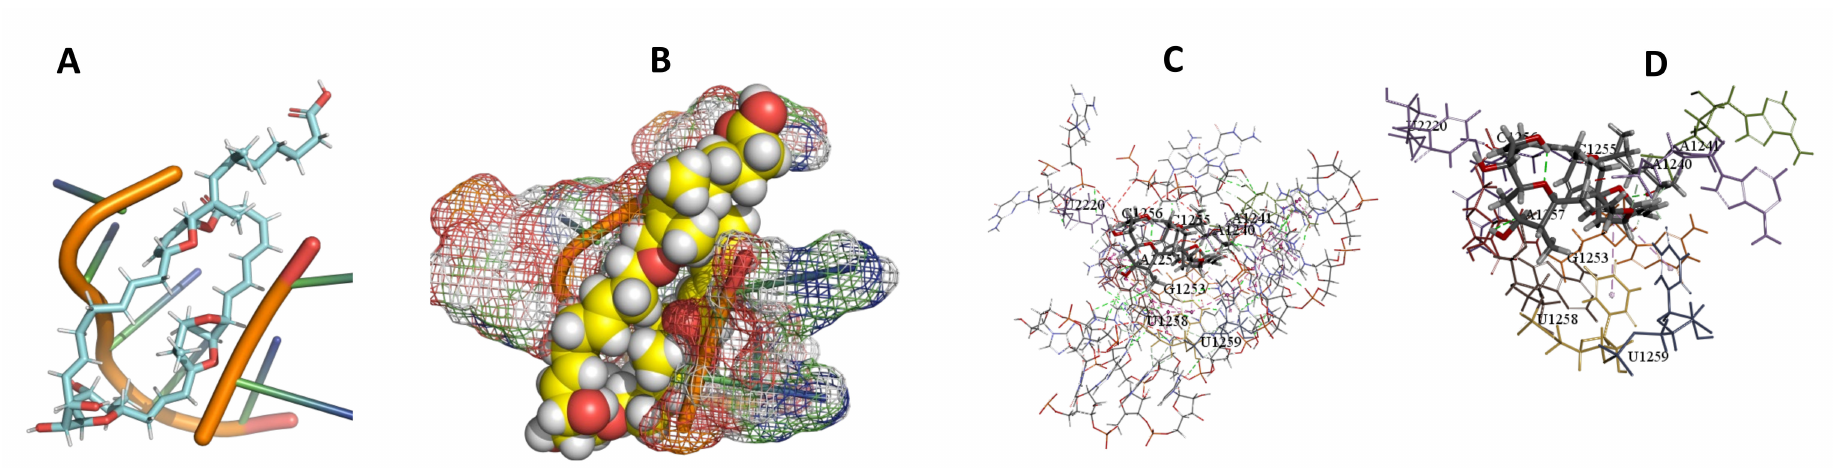
Figure 28. T. Brucei + Sorangicin. ( A ): Best binding pose and nucleotides involved. ( B ): Schematic binding pocket. ( C ): shows the Nucleotides component that re involved in binding. ( D ): Shows the main bonds involved between the compound and the nucleotide component.